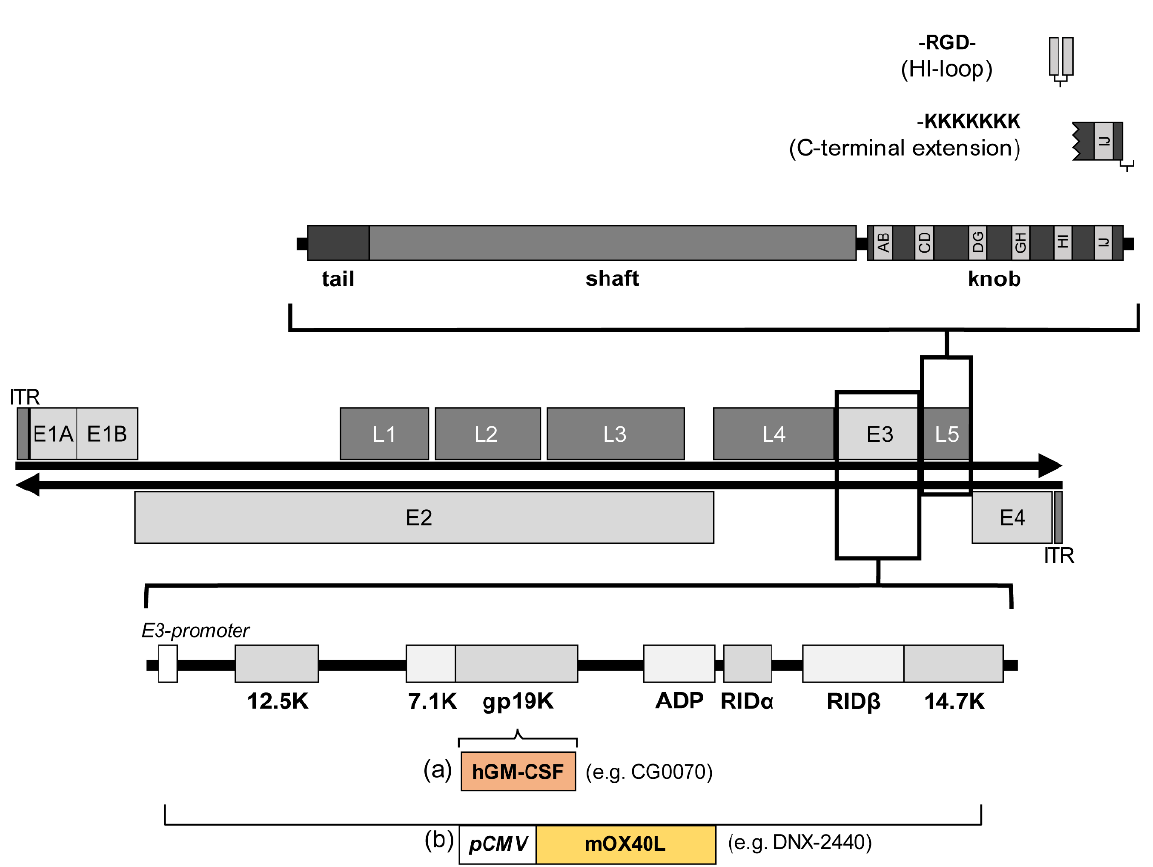
Figure 3. Structure of the wild-type adenovirus serotype 5 genome and the concepts for altering natural tropism by fibre modification (upper section) and incorporating transgenes into the adenoviral E3 region (lower section). The affected L5 region encodes for the fibre protein; fibre monomer with tail, shaft, and knob domains is enlarged in the upper section to illustrate the modifications. Incorporation of an Arg-Gly-Asp motif (RGD) into the HI-loop enables attachment to the host cell via integrins, and C-terminal extension of lysin residues at the fibre head via heparansulfate-containing receptors. The lower section illustrates the two concepts of incorporating transgenes into the E3 region: (a) Most of the E3 region is retained while a transgene like the human granulocyte-macrophage colony-stimulating factor (GM-CSF) in the adenoviral vector CG0070 is inserted, here GM-CSF expression is regulated by the E3 promoter. (b) Replacement of the E3 transcription unit with, for example, the pCMV-mOX40L-expression cassette in the adenoviral vector DNX-2440 where the expression of the mouse OX40L is regulated by the cytomegalovirus (CMV)